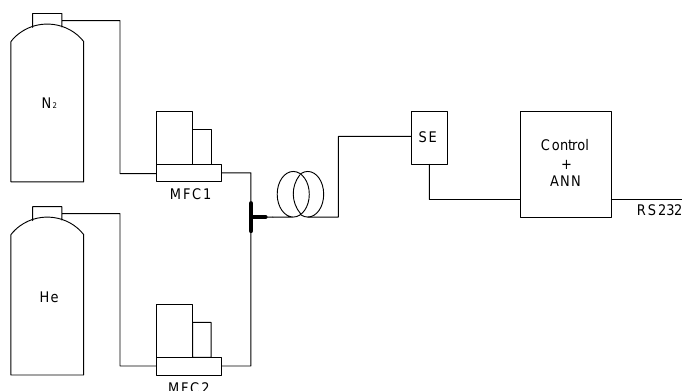
Figure 8. Experimental set-up for the intelligent gas-mixture flow sensor [47].